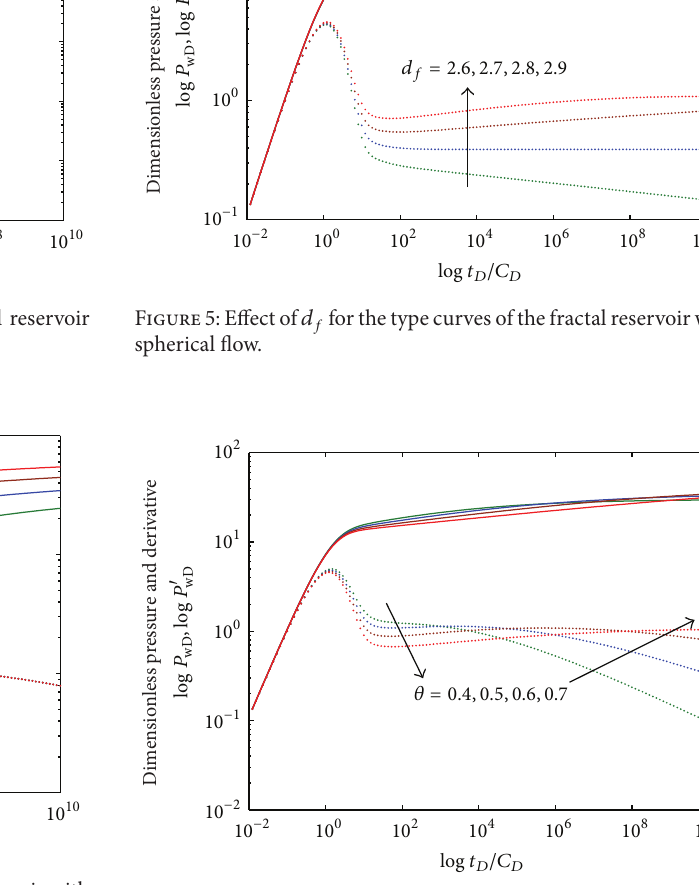
Figure 6: Effect of 𝜃 for the type curves of the fractal reservoir with spherical